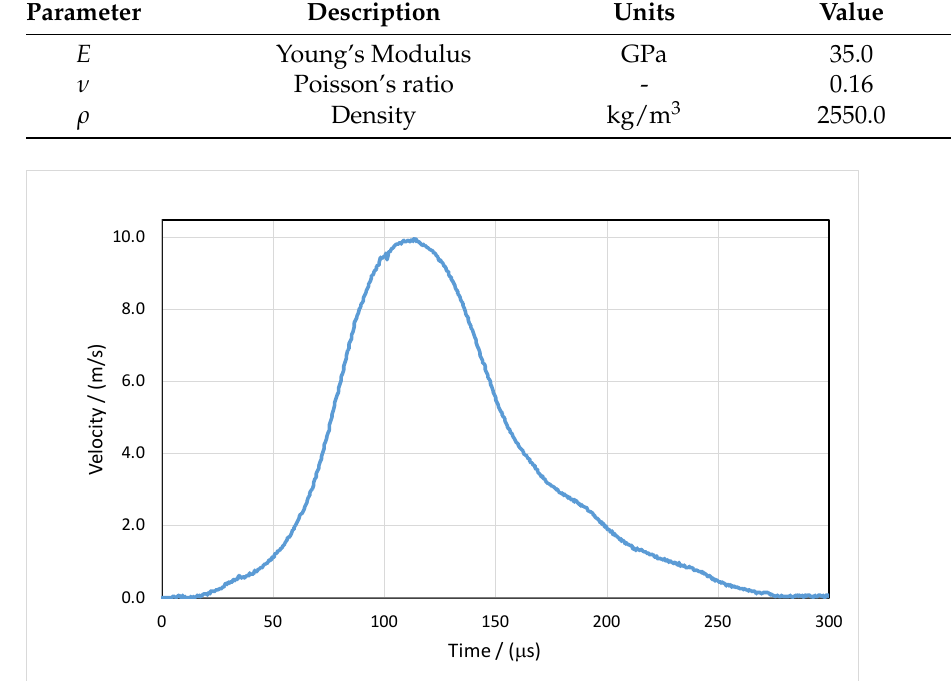
Figure 2. Time velocity curve of the SHPB experiment used in the HOSS